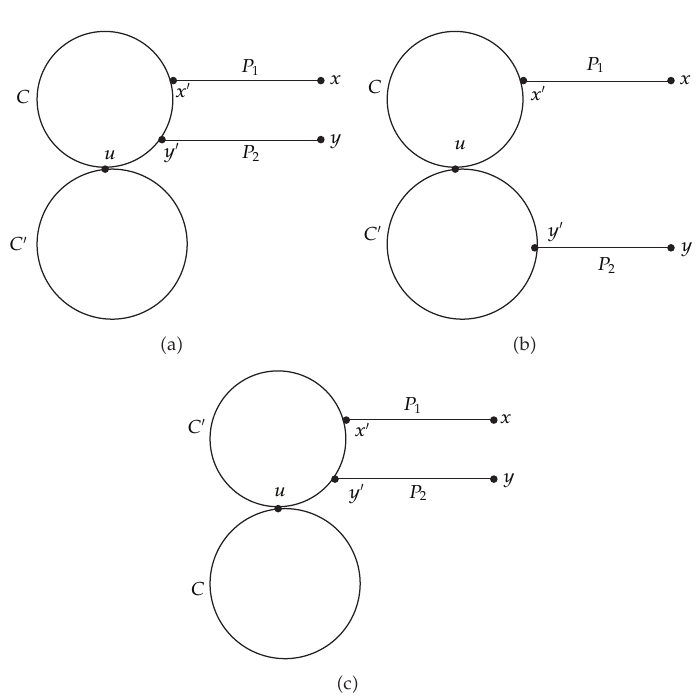
Figure 4: Illustrate for Subcase 1 . 2 . 3 of Lemma